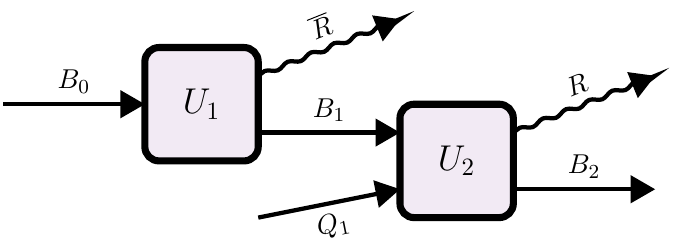
Figure 4 . A model for the black hole evaporation for the evaluation of the entropy of the subset of radiation S ( R ) . The B i are the black hole at times 0 , u 1 and u 2 . In order to model irreversible evaporation an auxiliary factor Q 1 must be added in as